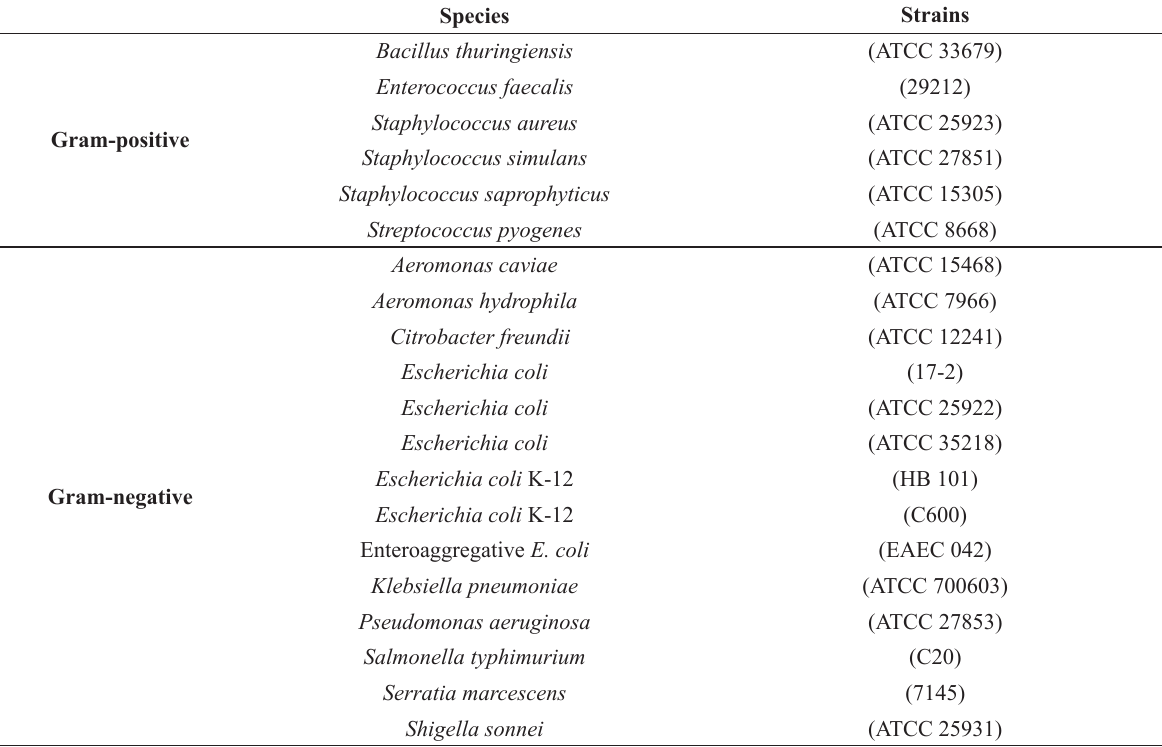
Bacterial strains used for the evaluation of antibacterial activity of different in vitro derived materials of Passiflora